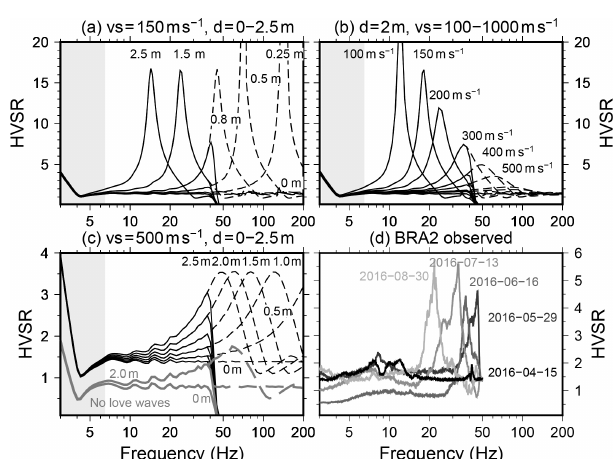
Figure 4. (a–c) HVSRs modeled using the diffuse wave field method and subsurface models of increasing thaw depth d or de- creasing S -wave velocity Vs in the active layer. The reference model in Table 1 is modified accordingly. Black models include Rayleigh, Love and body waves. Gray models in panel (c) include no Love waves. The gray area indicates tremor frequency band (see Sect. 5). Dashed curves are modeled HVSRs above the Nyquist frequency without using the anti-aliasing filter of field instruments. (d) Mea- sured HVSRs at station BRA2 on four different days showing a peak gliding to lower